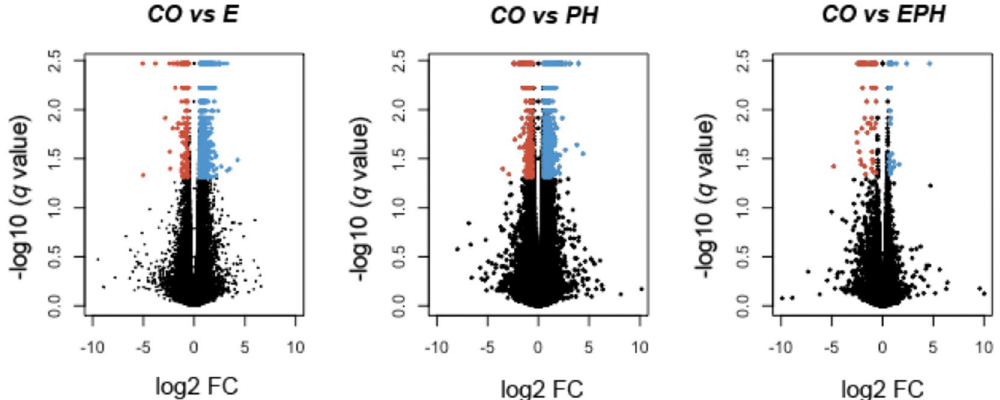
Figure 2. Volcano plots, showing genes with biased patterns of expression between individuals in the control group ( CO ) and the fish stressed during embryonic ( E ), post-hatch ( PH ) and embryonic and post-hatch ( EPH ) stages. Red dots represent genes with significantly lower abundances while the blue dots show genes with higher levels of expression. Values on the x- and the y-axes are log 2 fold change (FC) differences in the gene expression and negative log 10 of the corrected p values